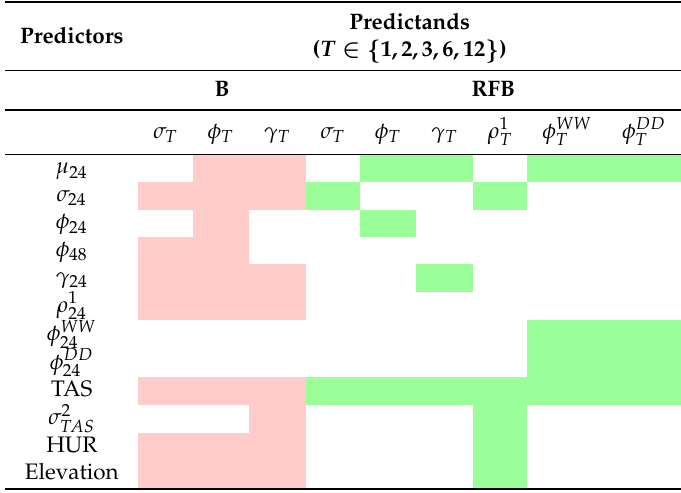
Table 3. Predictors used (first column of the table) by models B and RFB (heading row) for the prediction of each statistic (subheading row). Predictors are: average daily precipitation ( µ 24 ), daily precipitation variance ( σ 2 ), probability of a dry day ( φ 24 ), probability of two consecutive dry days ( φ 48 ), 24 daily rainfall skewness ( γ 24 ), lag-1 daily autocorrelation coefficient ( ρ 1 ), probability of two 24